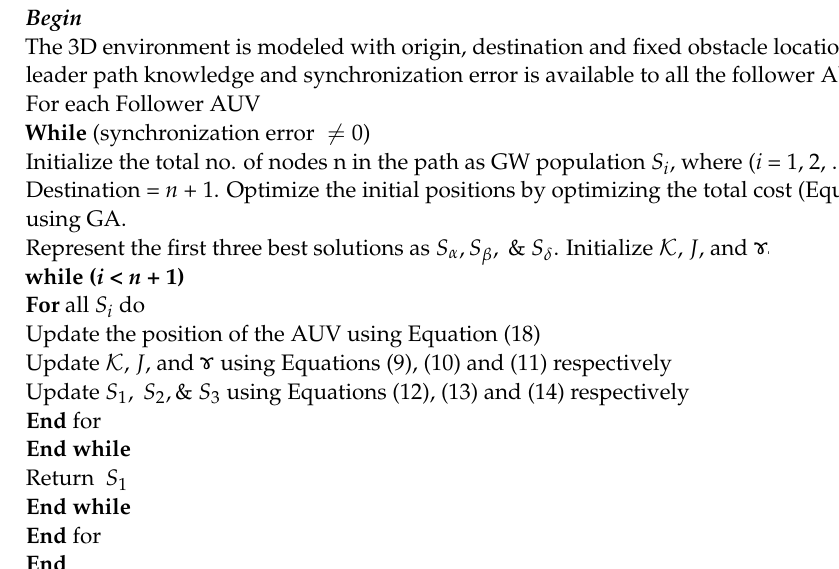
Algorithm 2. Pseudocode for cooperative path planning